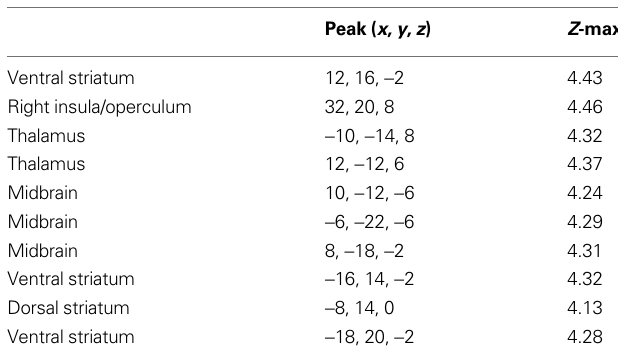
Table 3 | Charity, Gain $4 > Gain